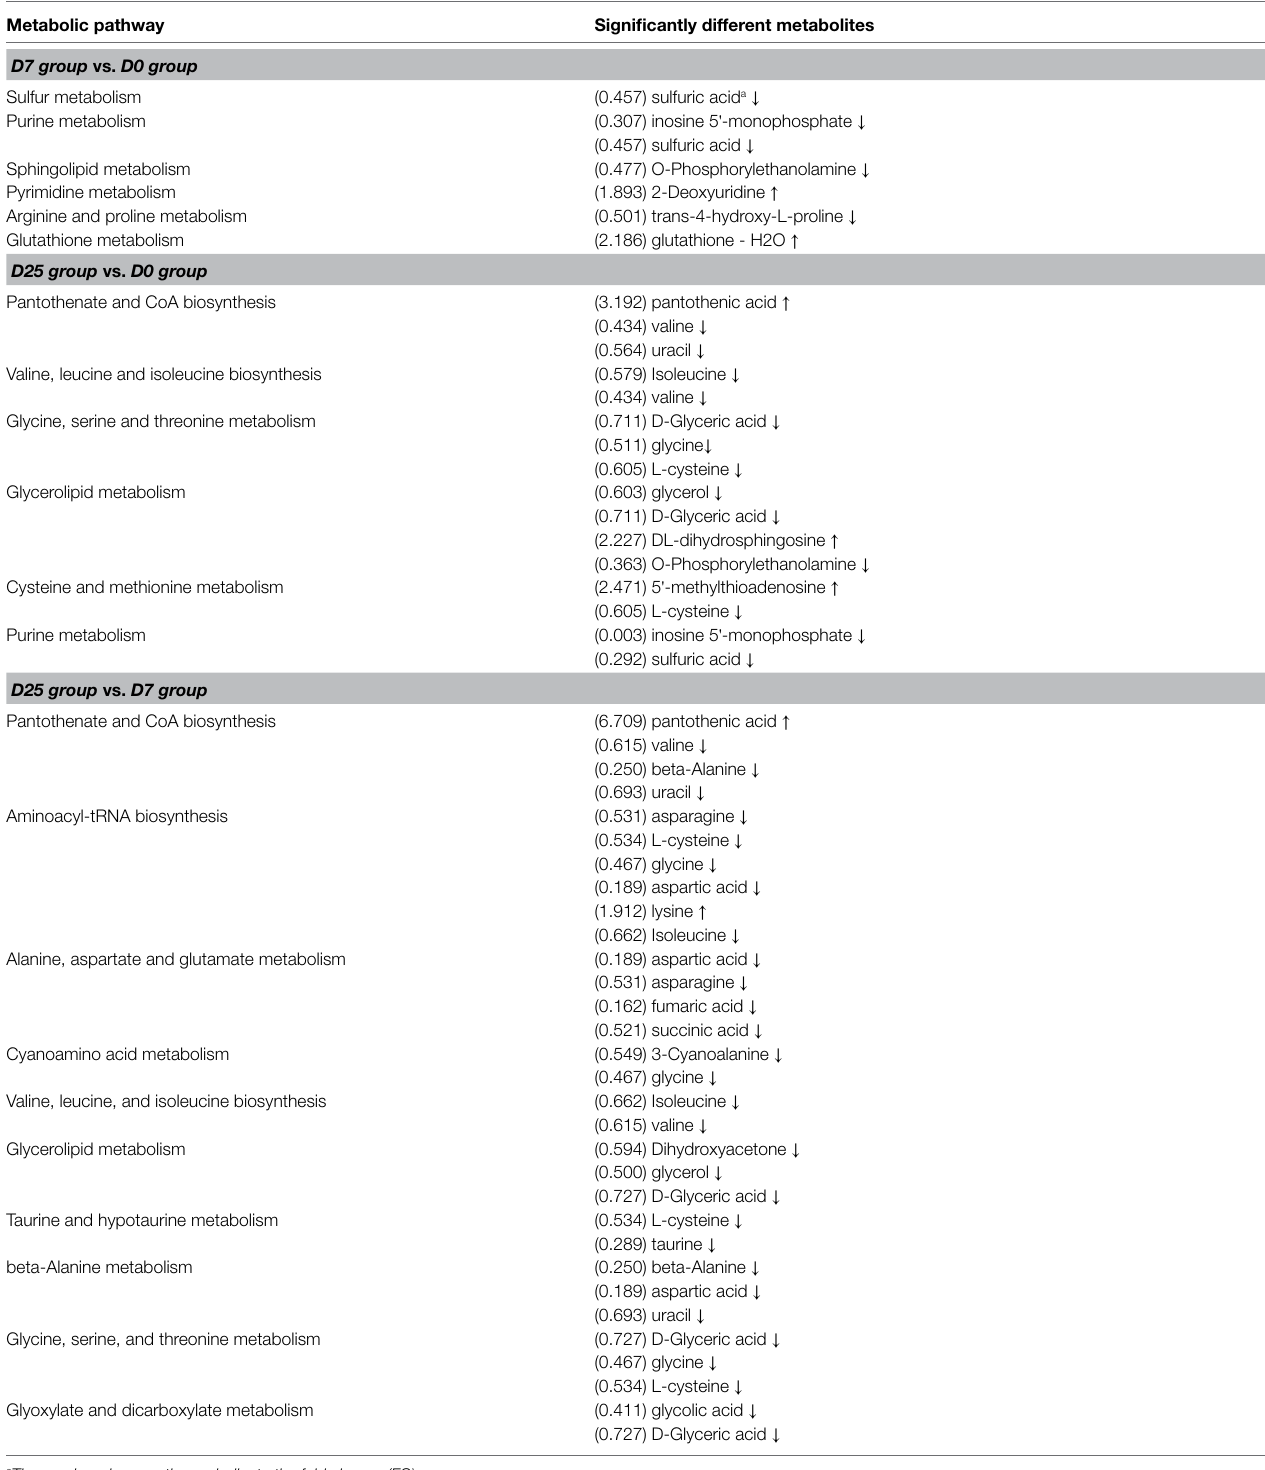
TABLE 2 | Metabolic pathways identified for the significantly different